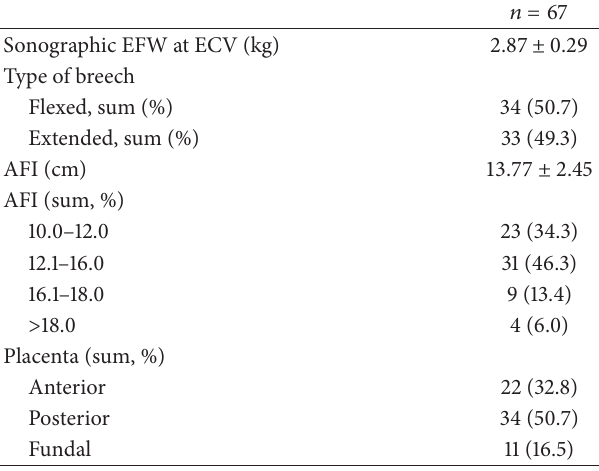
Table 1: Fetal characteristic at external cephalic version